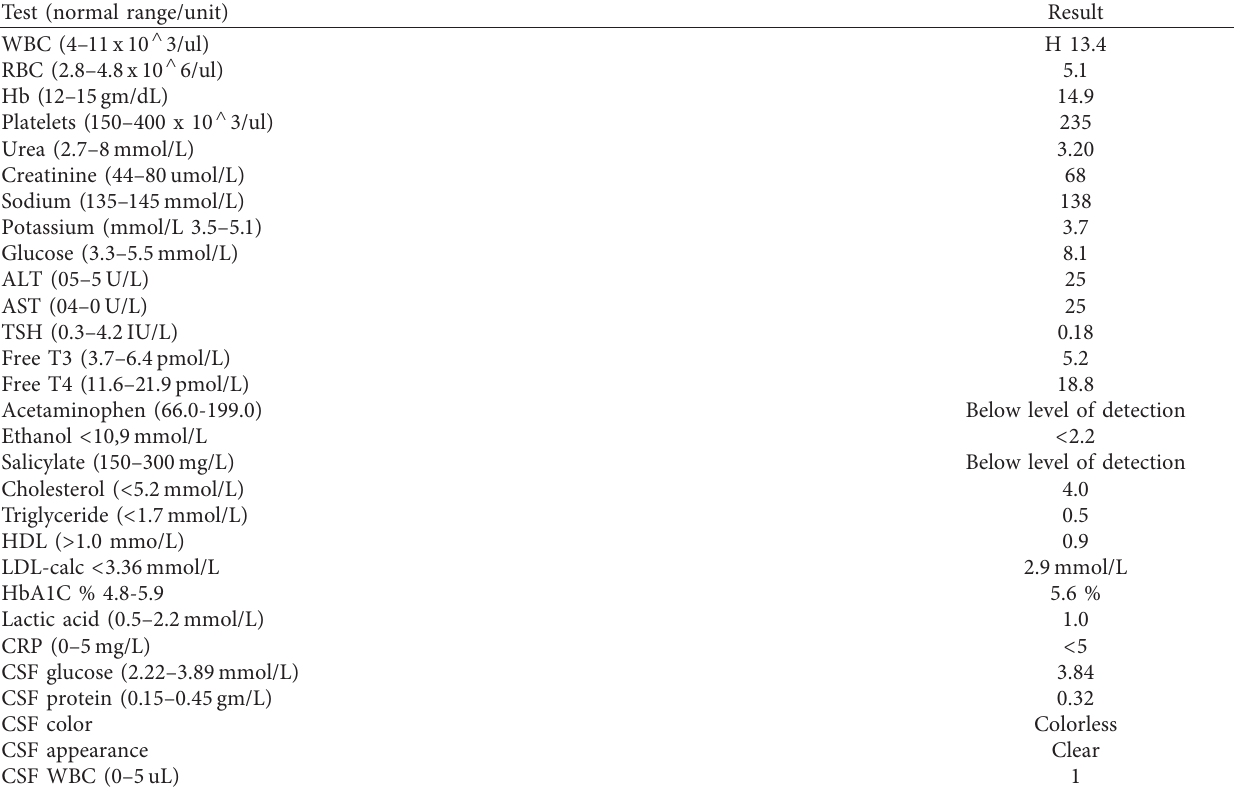
Table 1: The patient’s laboratory test